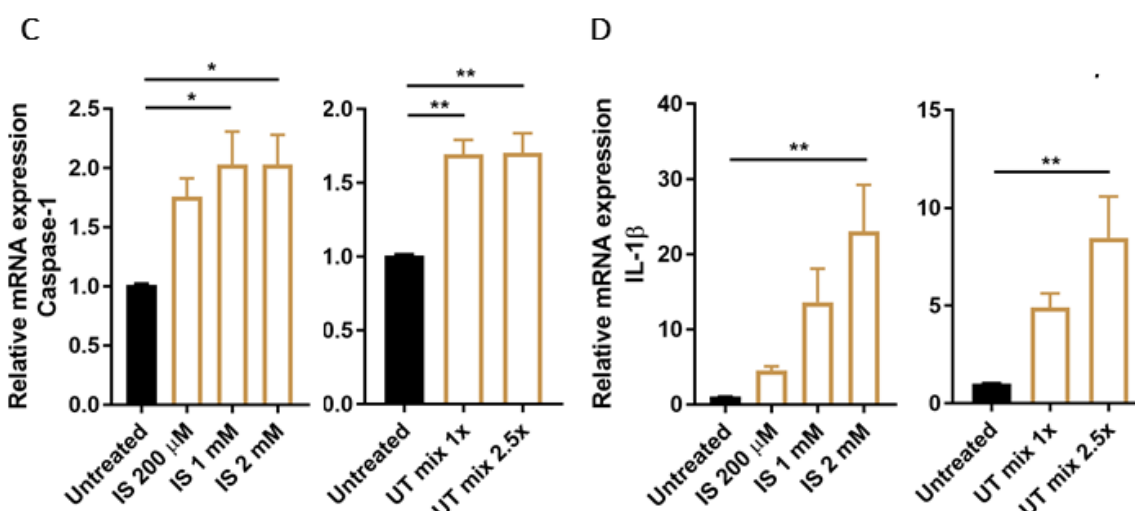
Figure 2. Expression of NLRP3 inflammasome related genes in ciPTEC-OAT1 after exposure to PBUTs. Relative mRNA expression of ( A ) NLRP3, ( B ) ASC, ( C ) caspase-1 and ( D ) IL-1 β upon exposure to either IS (200 µ M, 1 mM, 2 mM) or UT mix (1 × , 2.5 × ), compared to control (untreated ciPTEC-OAT1). Data are derived from three independent experiments performed in duplicate and expressed as mean ± SEM. * p < 0.05, ** p < 0.01 (One-way ANOVA followed by Dunnett’s multiple comparison test, using untreated cells as a control).